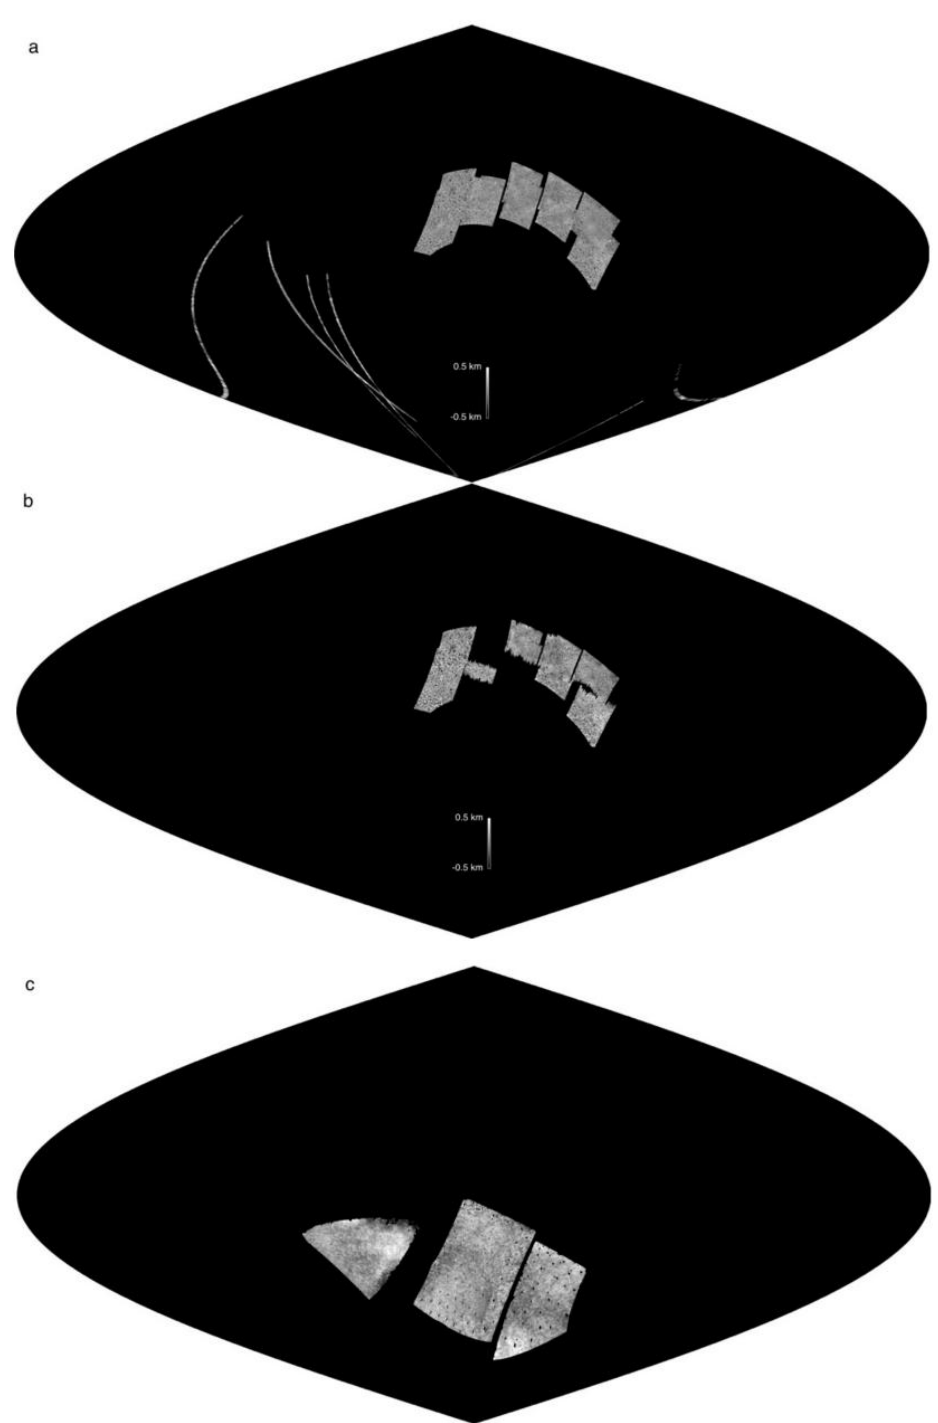
Figure 3. ( a ) Global sinusoidal maps showing distribution of stereogrammetric (SG) DEMs for Triton and curvilinear limb profile tracks provided by [23]. Only those stereo DEMs where geologic features are nominally resolved are shown. Map area also corresponds to VTERM CA mosaic outline and coincident PC-DEM. Map limits from − 180 to 180 ◦ E longitude. ( b ) The figure is same as Figure 3a, except limb tracks are not shown and with those parts of SG-DEM affected by truncated reseaux marks and potential uncertainties in geometric correction masked out. The areas shown are, in principle, not affected by reseaux truncations. ( c ) SG-DEMs of southern hemisphere terrains. Undulations are not regarded as reliable, due to low stereo sensitivity of the input stereo